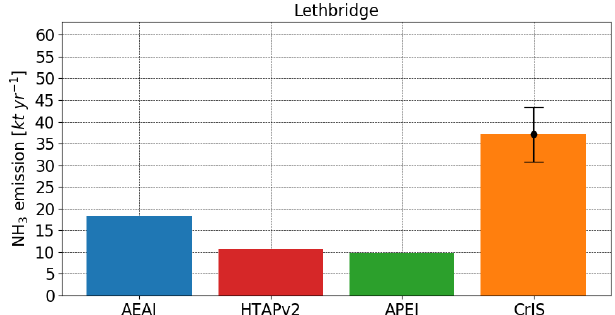
Figure 16. The bars show the Lethbridge regional emissions as in the AEAI (blue), HTAPv2 (red), and APEI (green) inventories summed over a box with a bottom-left corner of (49.35 ◦ , − 113.31 ◦ ) and a top-right corner of (50.28 ◦ , − 111.10 ◦ ). The orange bar shows the CrIS estimated emissions using the free fitting algorithm and adjusted for diurnal and seasonal variability. The vertical error bar shows the uncertainty of the CrIS estimate that includes the uncer- tainty in the fit, the total columns, and uncertainties due to the me-